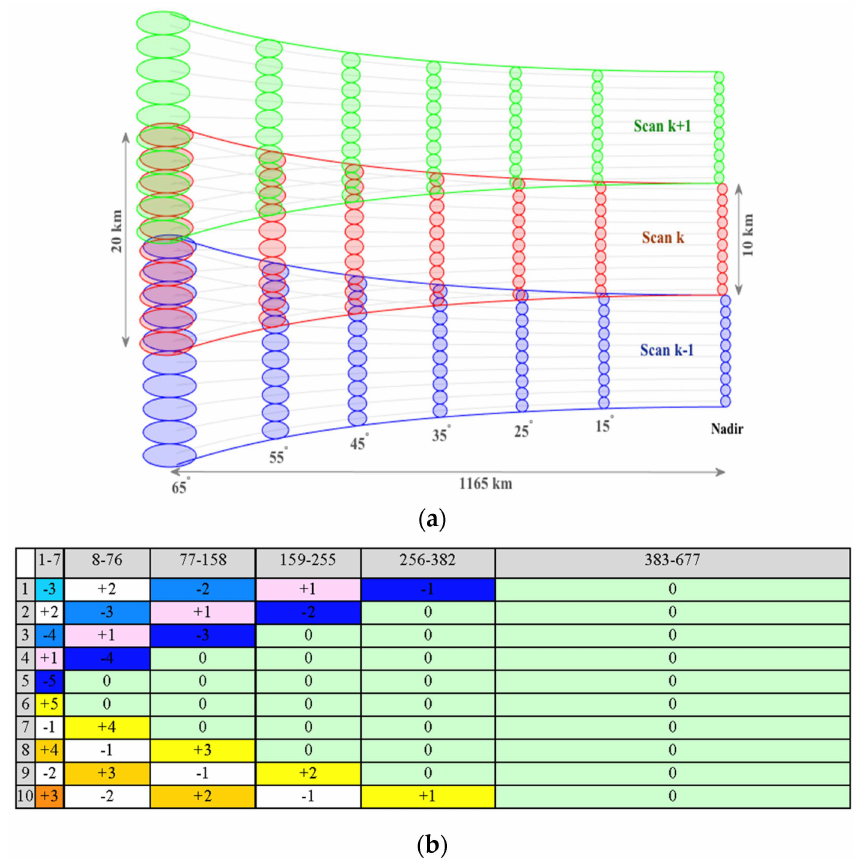
Figure 12. ( a ) Schematic representation of Moderate Resolution Imaging Spectroradiometer (MODIS) sampling for three consecutive whiskbrooms (rendered in blue, red and green respectively), for several selected VZAs from 0 ˝ (nadir) to 65 ˝ (approximately representing the left edge of the scan) in 10 ˝ increments. The two axis of each ellipse represent the horizontal and vertical sampling intervals, respectively; ( b ) The reordering scheme for the left half of the MODIS